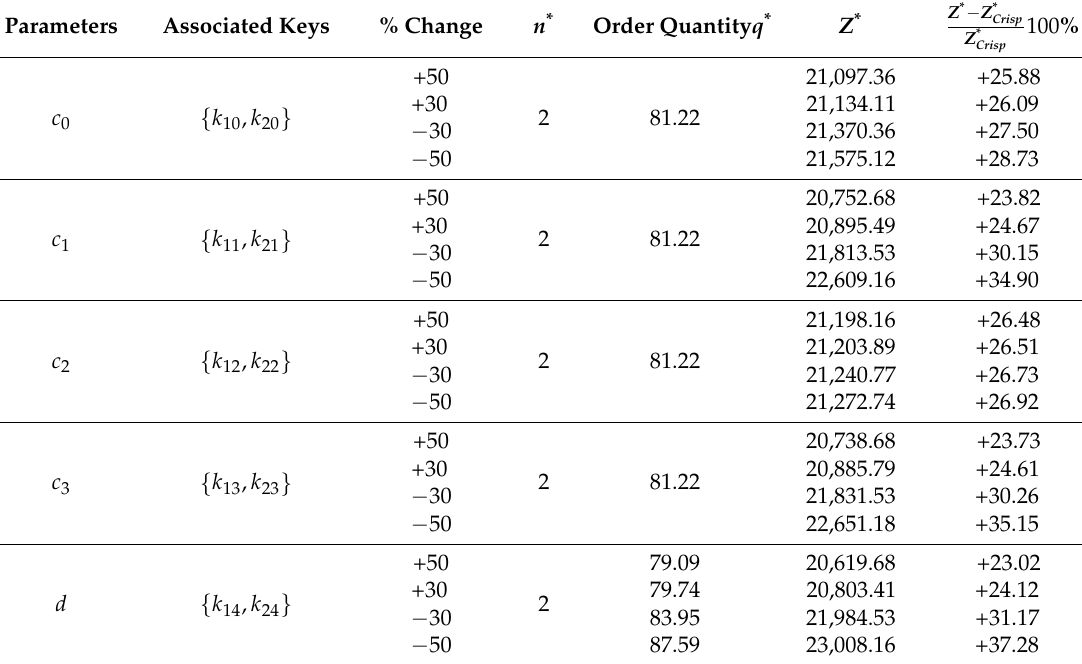
Table 4. Sensitivity analysis for Model